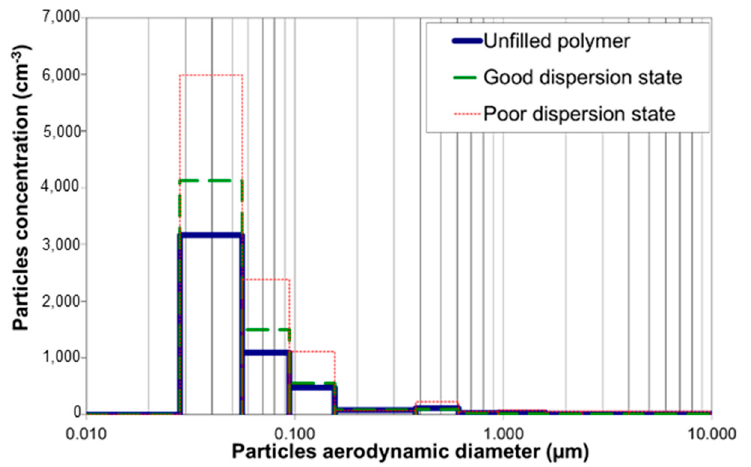
Figure 16. Granulometric distribution of released particles during the use of the steel brush on DGEBA / DDS samples (electrical low pressure impactor (ELPI) data